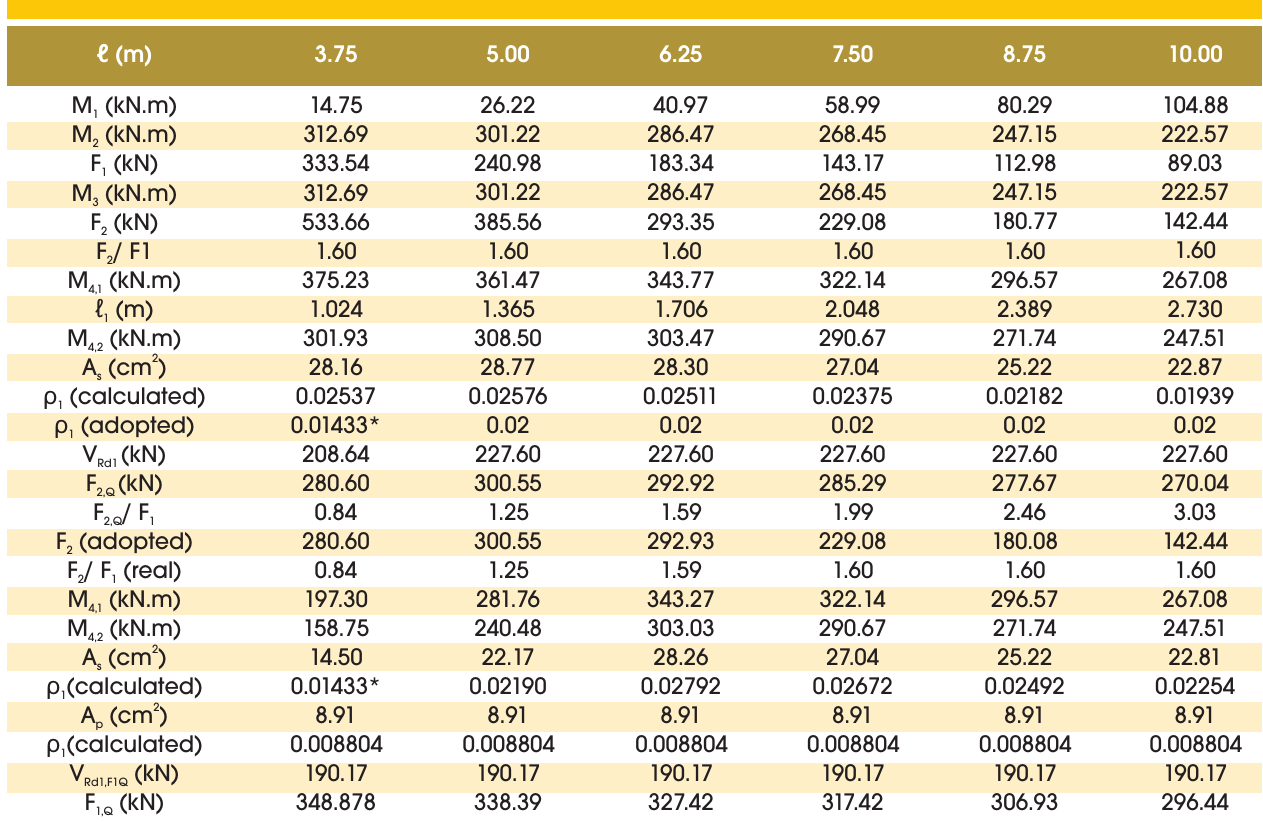
Table 7 – Simulation of tests for spans between 3.75 m and 10.00 m